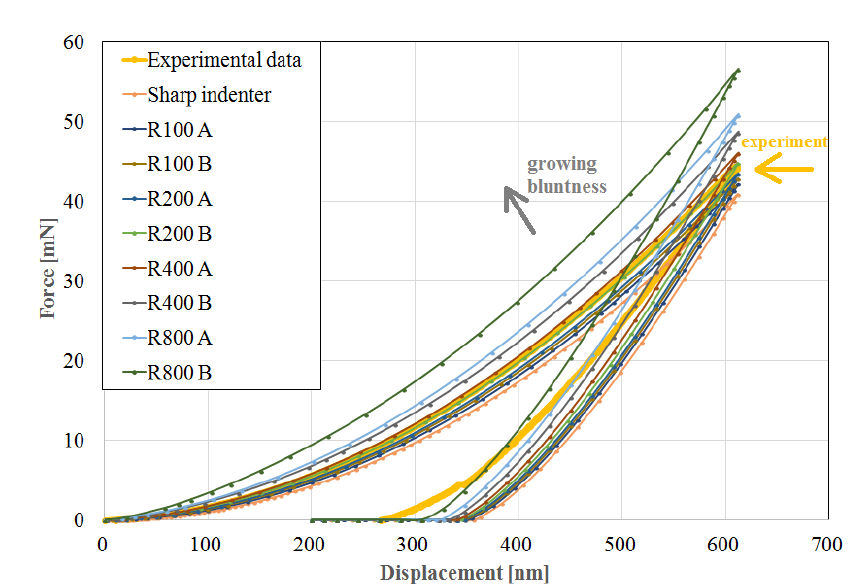
Figure 5. Indentation curves for all cases.